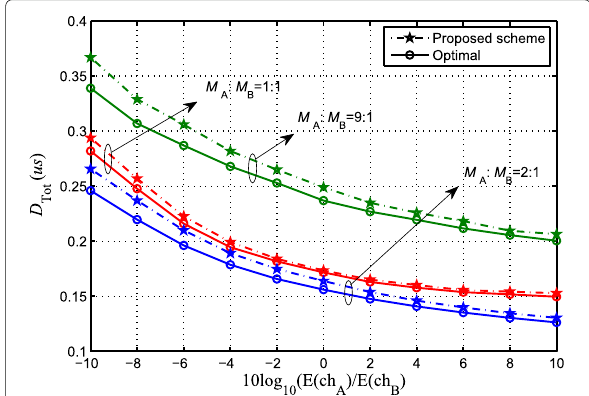
Fig. 6 D Tot performance comparison of optimal and proposed suboptimal algorithms